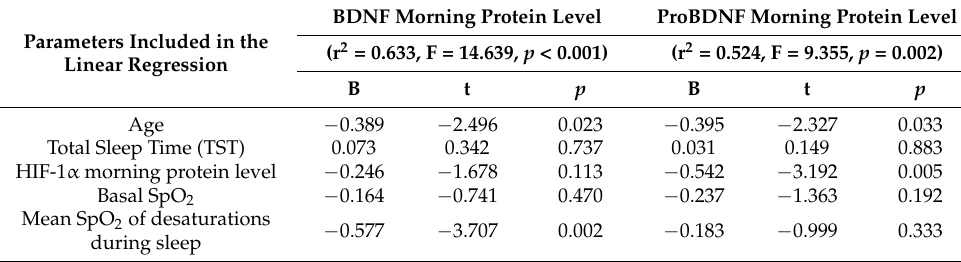
Table 2. Linear regression models for the morning BDNF and proBDNF protein levels in OSA